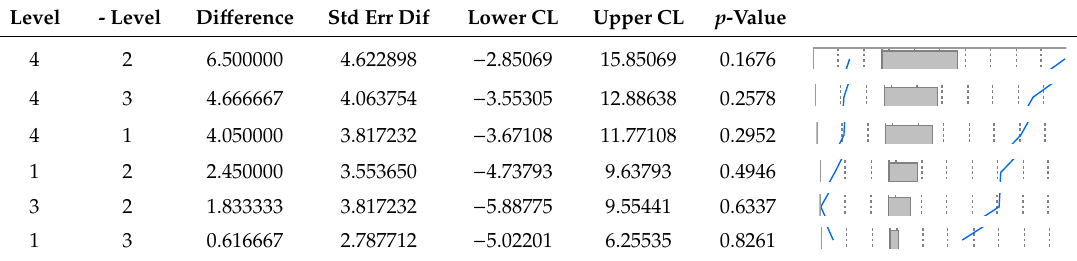
Table 4. Ordered difference report—recommended rotation age.